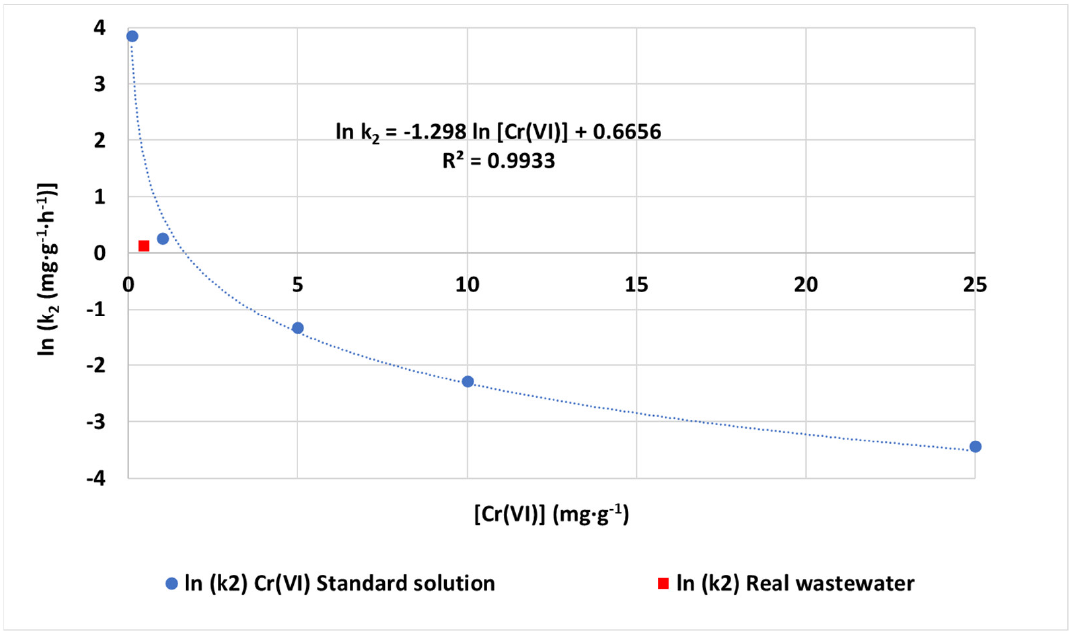
Figure 12. Evolution of PSO kinetic constant (k 2 ) while treating synthetic waters under varied initial chromium concentrations (0.1–25 mg · L − 1 ) and real wastewater at pH 3 and 100 mg · L − 1 of adsorbent dosage and logarithmic fitting of k 2 values of synthetic waters.